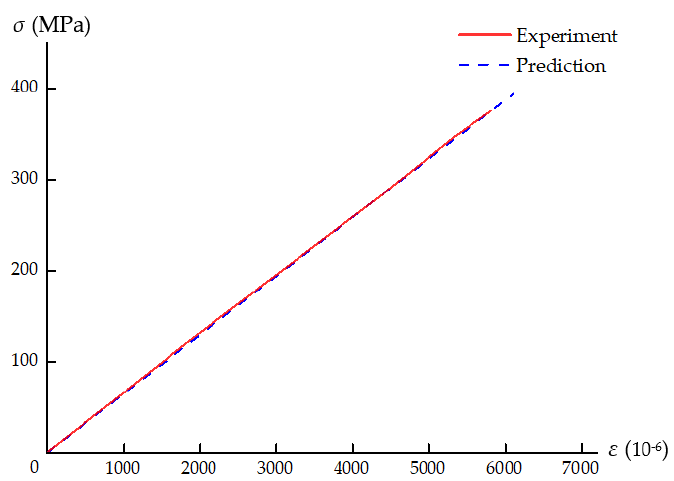
Figure 10. Experimental and numerically predicted axial average stress–strain curves.